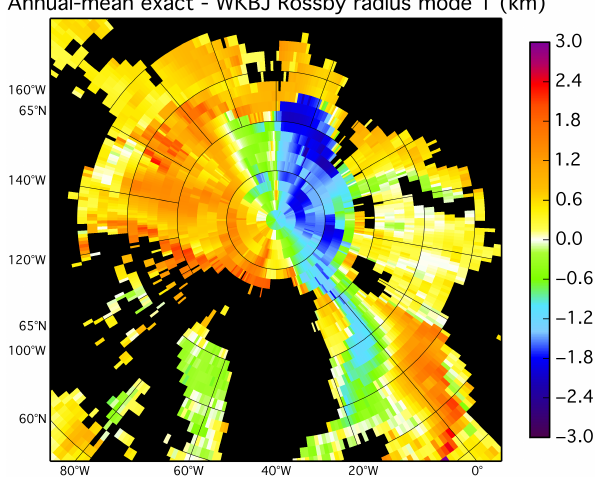
Figure 7. Difference between exact solution and WKBJ/LG approx- imate solution (exact minus WKB) for mode 1 Rossby radius (km), annual mean.